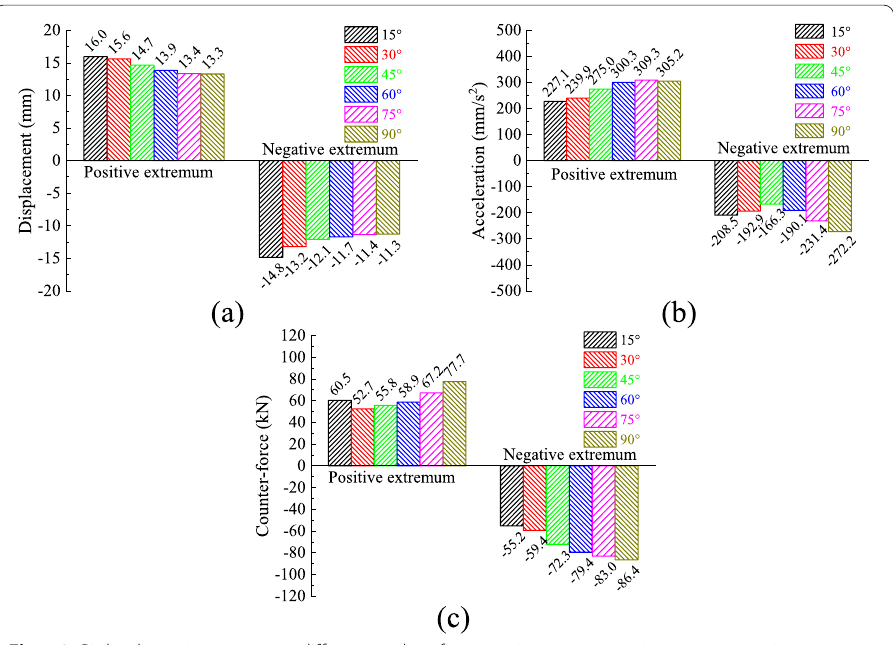
Fig. 16 Girder dynamic response at different angles of intersection in construction stage: a maximum displacement value; b maximum acceleration value; c maximum counter-force of the temporary